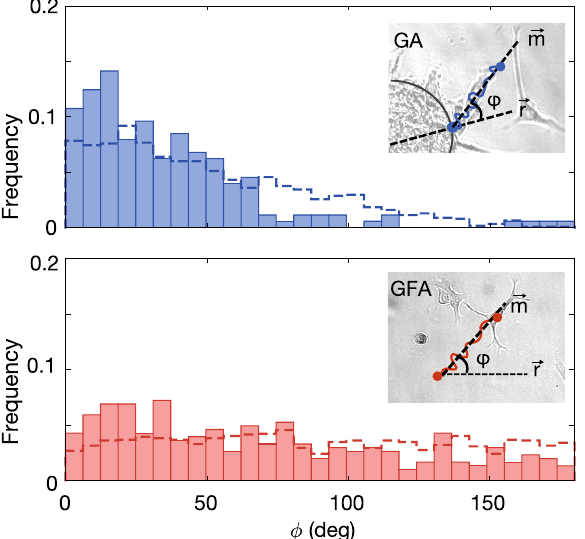
Figure 3. Distribution of angle, ϕ , between the major axis, m , and initial radial direction, r , for data (bars) and simulation (dashed line) from GA (N = 177) and GFA (N = 305). Insets: Schematic of the angle ϕ between major direction of motion, m , and initial radial direction, r for GA and GFA,